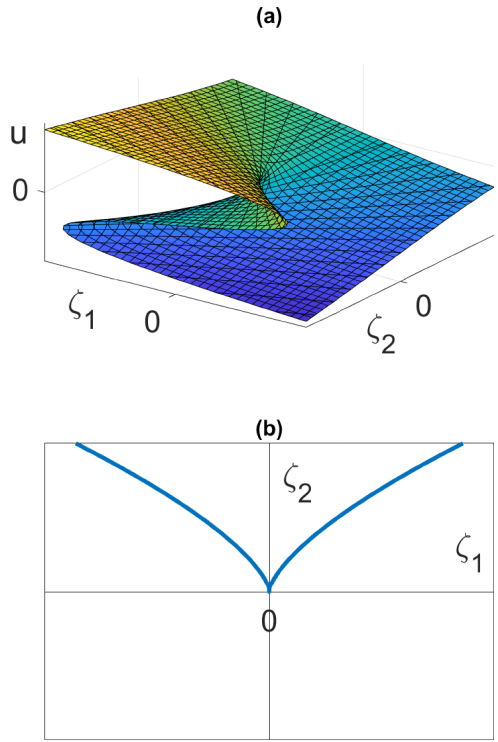
Figure 3. Cusp bifurcation diagram for the EBM in normal form coordinates. (a) Graph of the equilibrium surface with normal form unfolding parameters (ζ 1 ,ζ 2 ) . (b) Projection of this surface in 3- D onto the (ζ 1 ,ζ 2 ) plane. The blue semi-cubic parabola represents fold bifurcations, and it separates the (ζ 1 ,ζ 2 ) plane into two open 2- D regions. Inside the cusp region , that is between the two branches of the semi-cubic parabola, there exist three equilibrium solutions u : two stable and the middle one unstable. Outside of the semi-cubic parabola there exists only one unique equilibrium solution u and it is